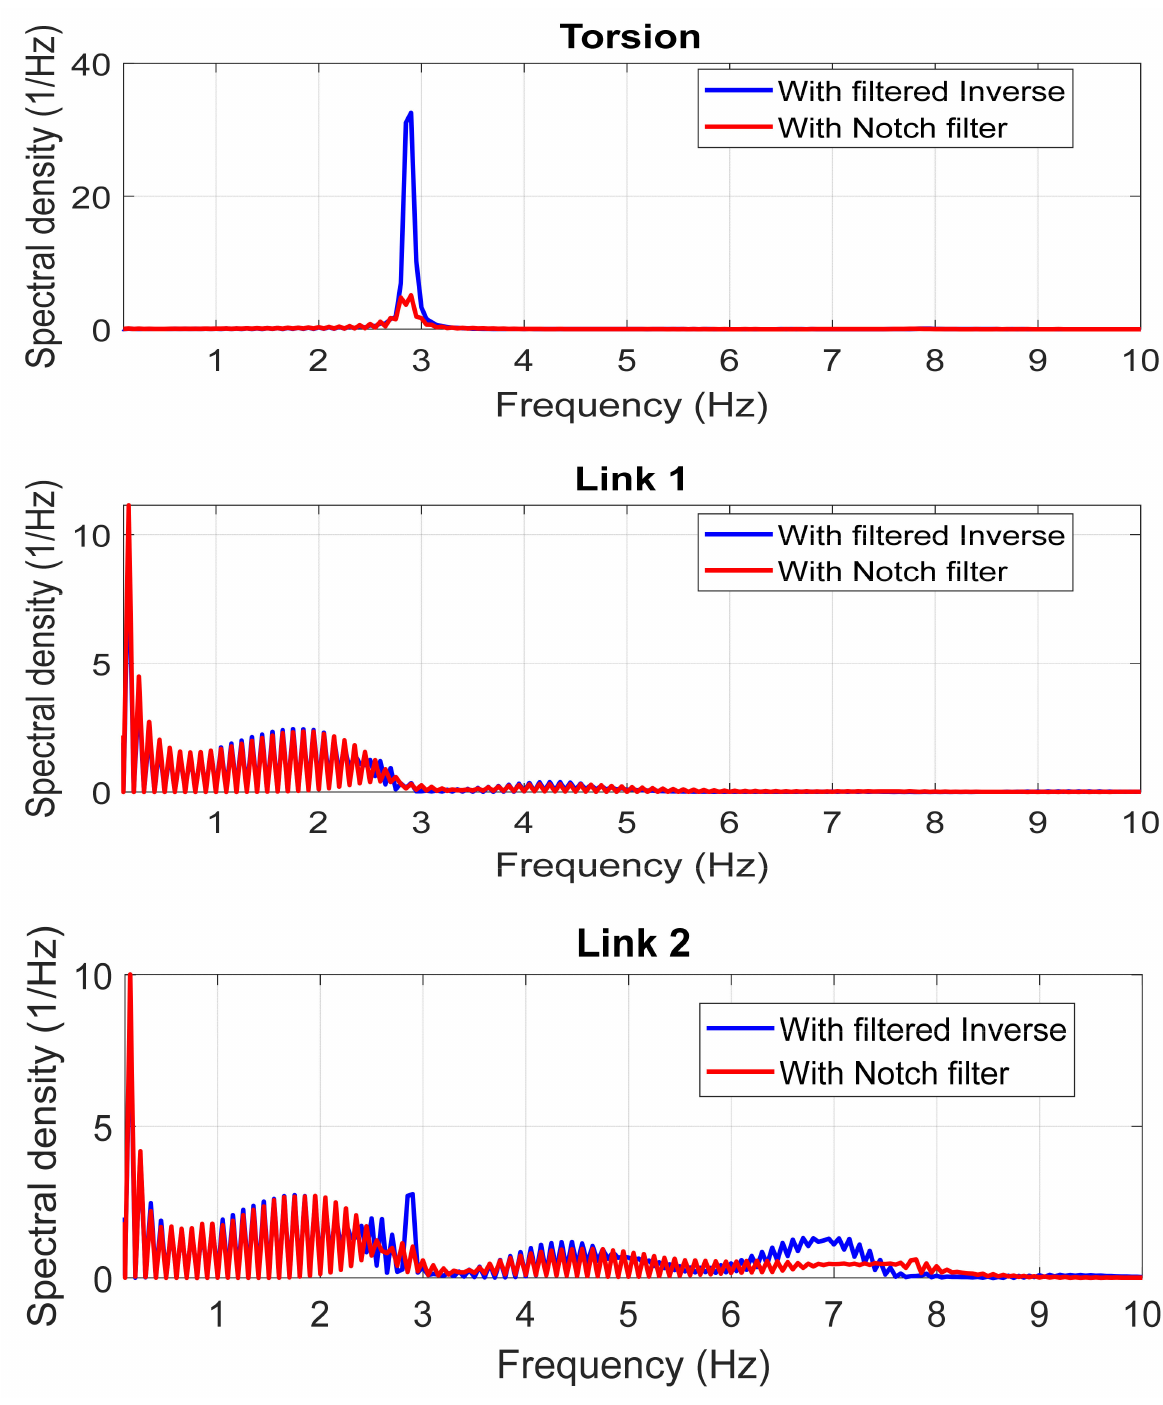
Figure 12. Strain spectral power